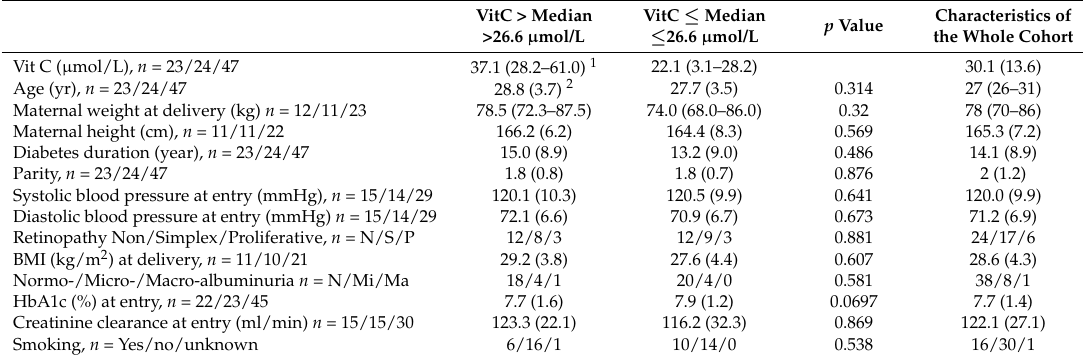
Table 1. Clinical data and characteristics of the diabetic status by maternal vitamin C (vitC) within the last four weeks of pregnancy ( n = 23/24) and of the whole cohort ( n = 47).